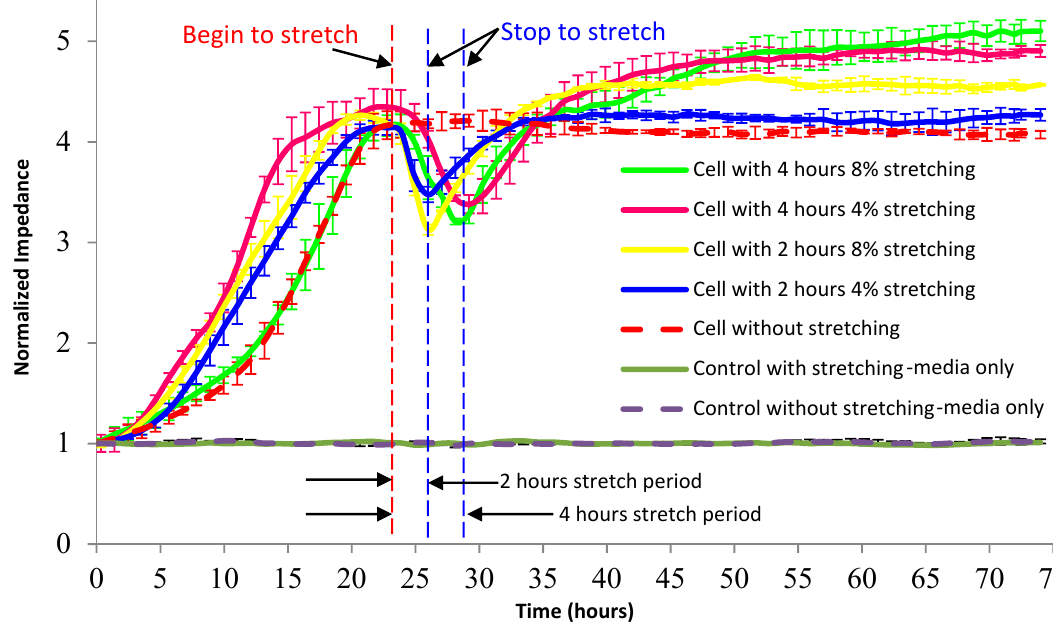
Figure 11. Normalized impedance response of cells and cell culture medium from the stretchable impedance sensors ( n = 3). The 4% or 8% stretch with 1 Hz was only applied from 24 h to 26 h or from 24 h to 28 h. The controls only contained cell culture medium, copied with permission from [82].